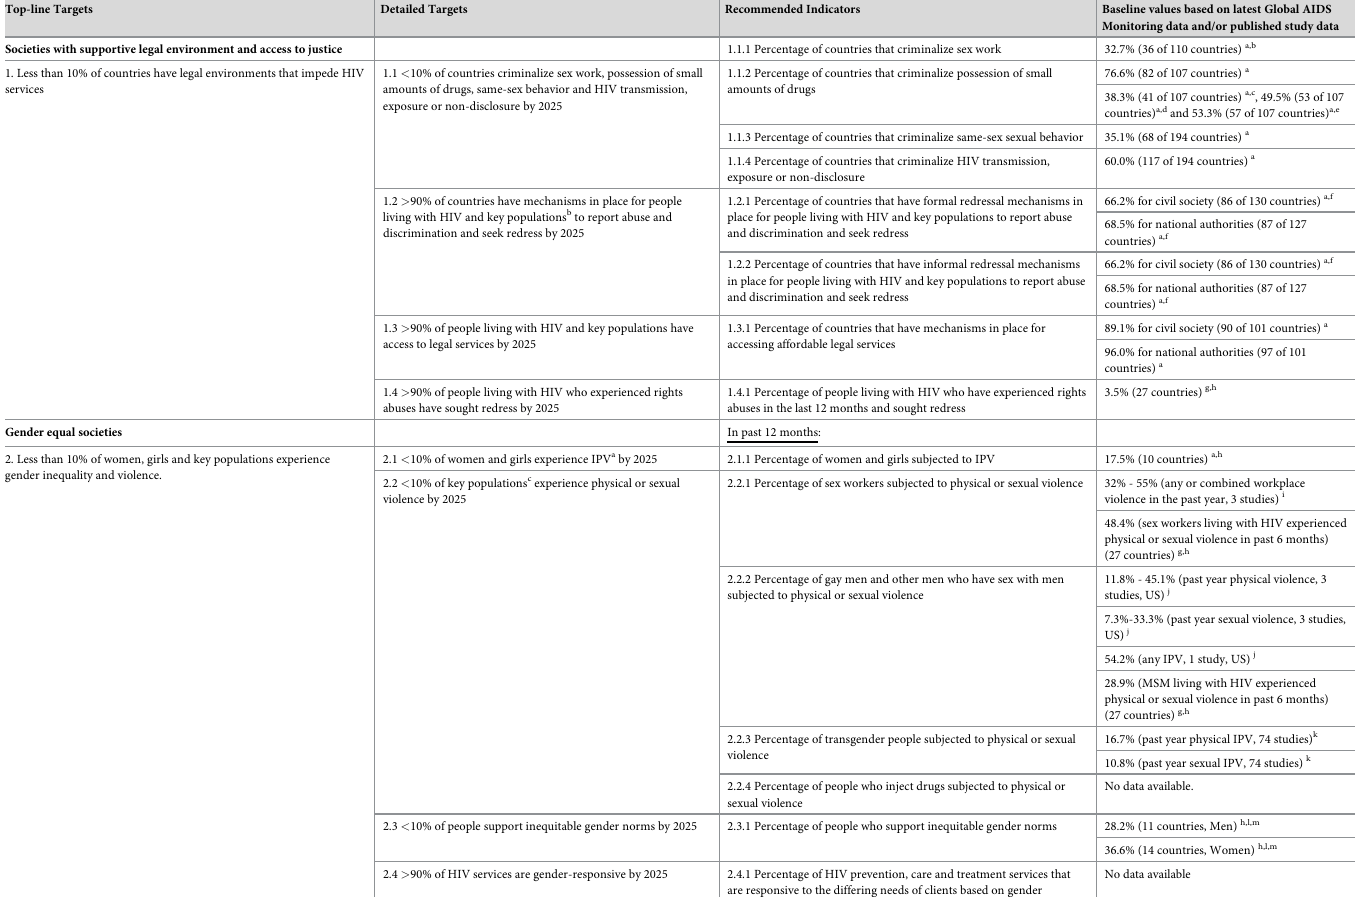
Table 2. Societal enabler targets for achievement by 2025 in the HIV sector and recommended indicators to assess progress.